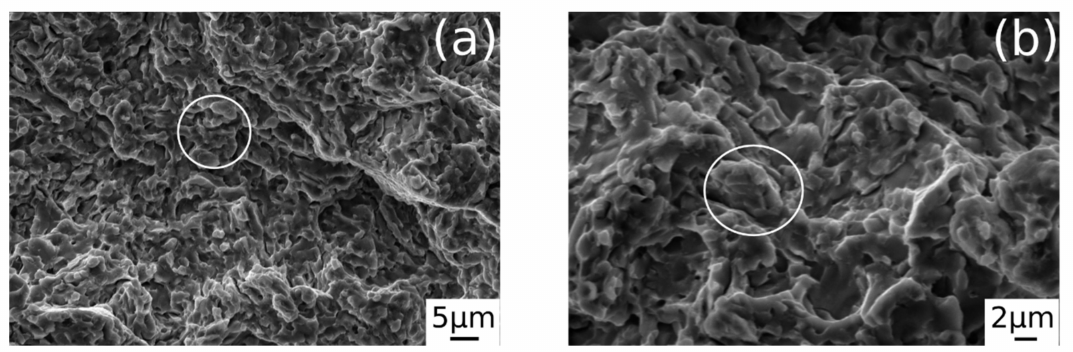
Figure 17. SEM fractography showing the fracture surface (in white cyrcles) revealing cleavage facets in Austempered samples ( a ) and ( b